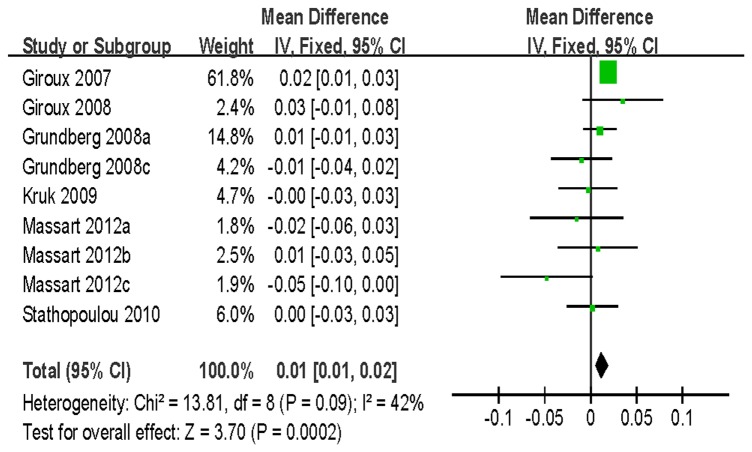
WMD and 95% CI in FN BMD between V667M VV and VM/MM genotypes.